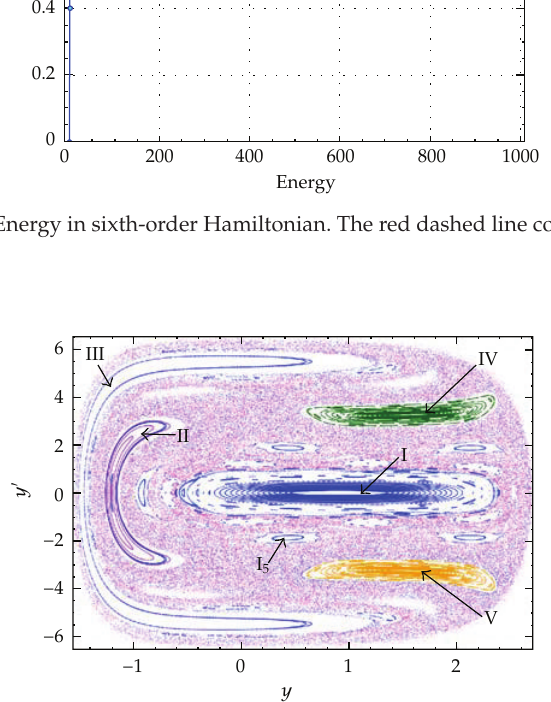
Figure 13: Poincar´e surface of section at E (cid:7) 20 (cid:5) in 20th-order Hamiltonian (cid:6)